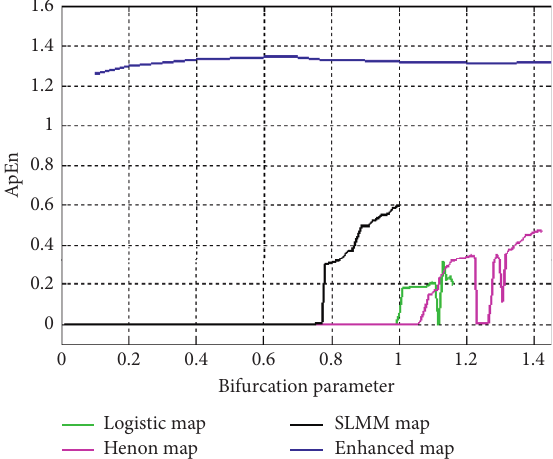
Figure 4: Approximation entropy comparison of 2D chaotic lo- gistic map, Henon map, SLMM map, and proposed hyperchaotic